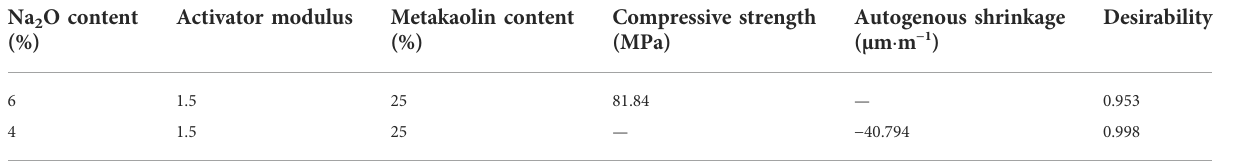
TABLE 6 Optimal combinations of target responses.